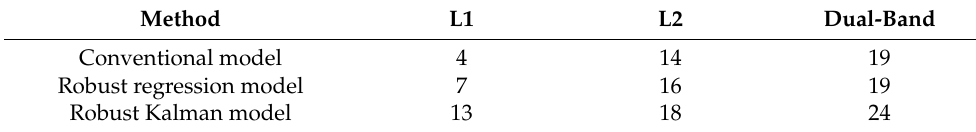
Table 1. Number of effective satellites used amplitude on each band.